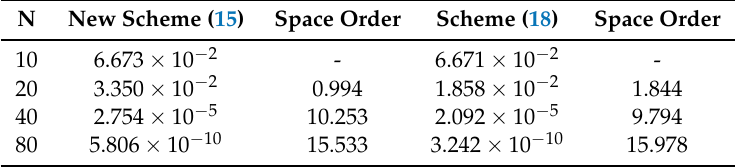
Table 2. Space accuracy test for the scheme (15) and the scheme (18) at t =